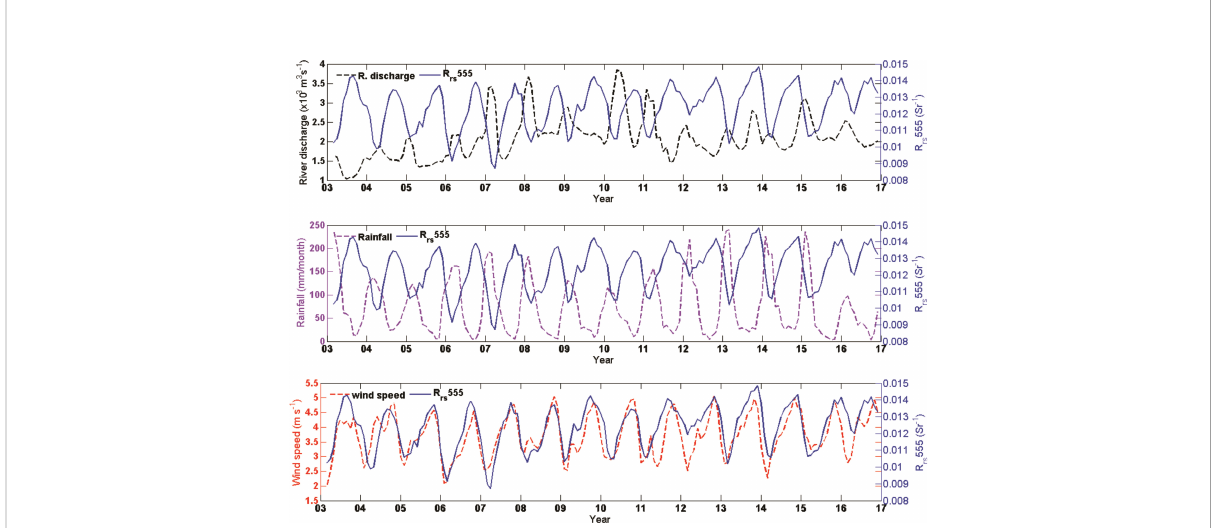
FIGURE 6 Overlap of monthly time series of river discharge with R rs 555 (upper panel), rainfall in Zambezi Delta with R rs 555 (middle panel), and wind speed with R rs 555 (lower